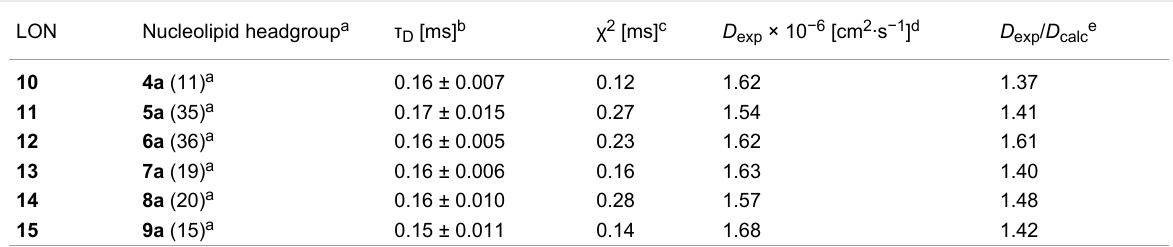
Table 4: Experimental hydrodynamic data from FCS measurements. LON